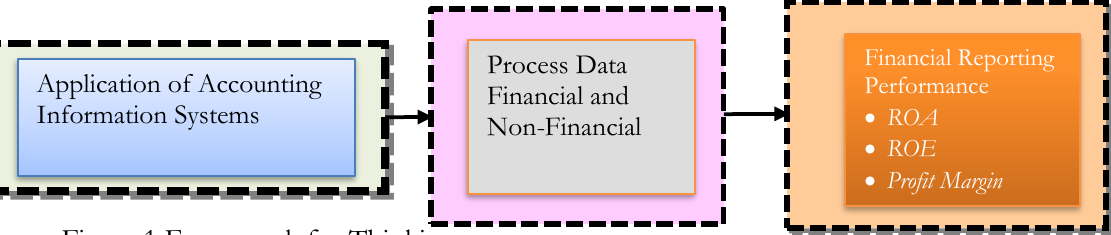
Figure 1 Framework for